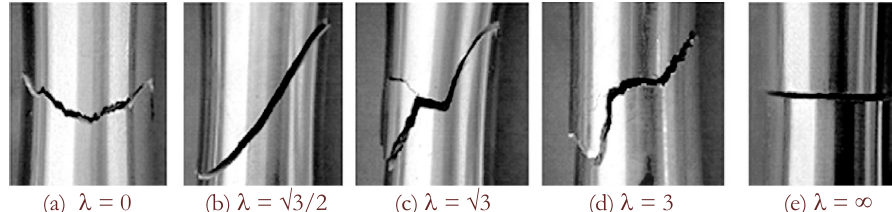
Figure 4: In-phase fracture appearance under different stress amplitude ratios [11].